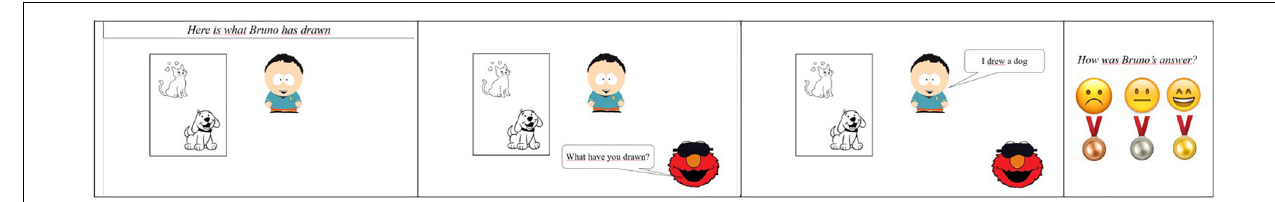
FIGURE 1 | Exemplification of a critical trial involving the violation of the maxim of Quantity.